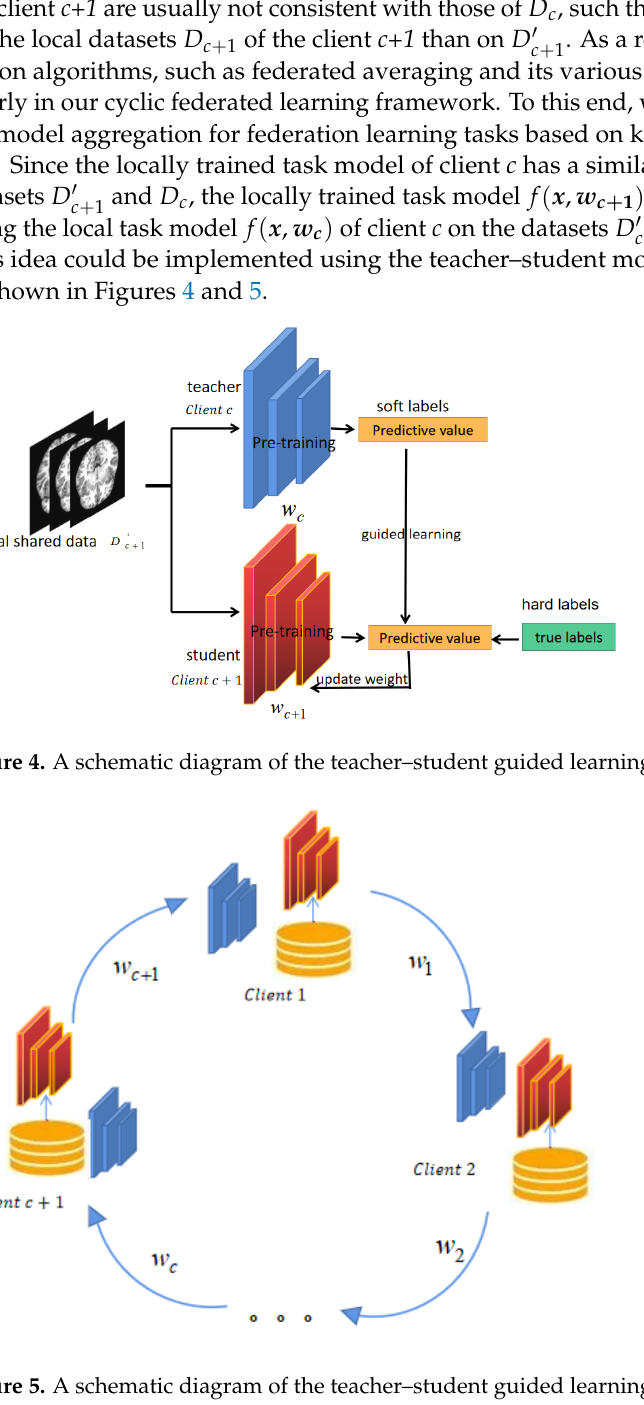
Figure 5. A schematic diagram of the teacher–student guided learning